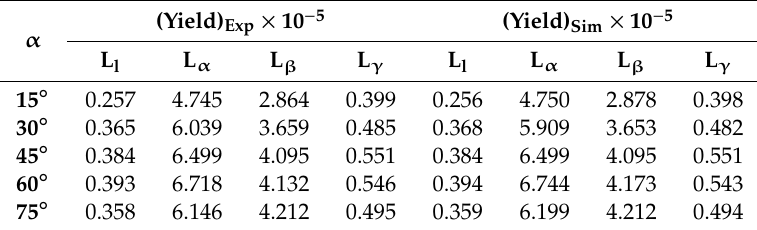
Figure 3. Typical graphs showing variation of the measured relative intensity of ( a ) L l , ( b ) L α , ( c ) L β and ( d ) L γ X-ray lines respectively, produced in collisions of 25 keV electrons with a pure polycrystalline thick W target as a function of incidence angle α . The black squares with error bars represent the measurements and the red circles denote the simulation results. The experimental data have been normalized to theory at α = 45°. Table 3. Same as Table 1 for impact energy of 25 keV.